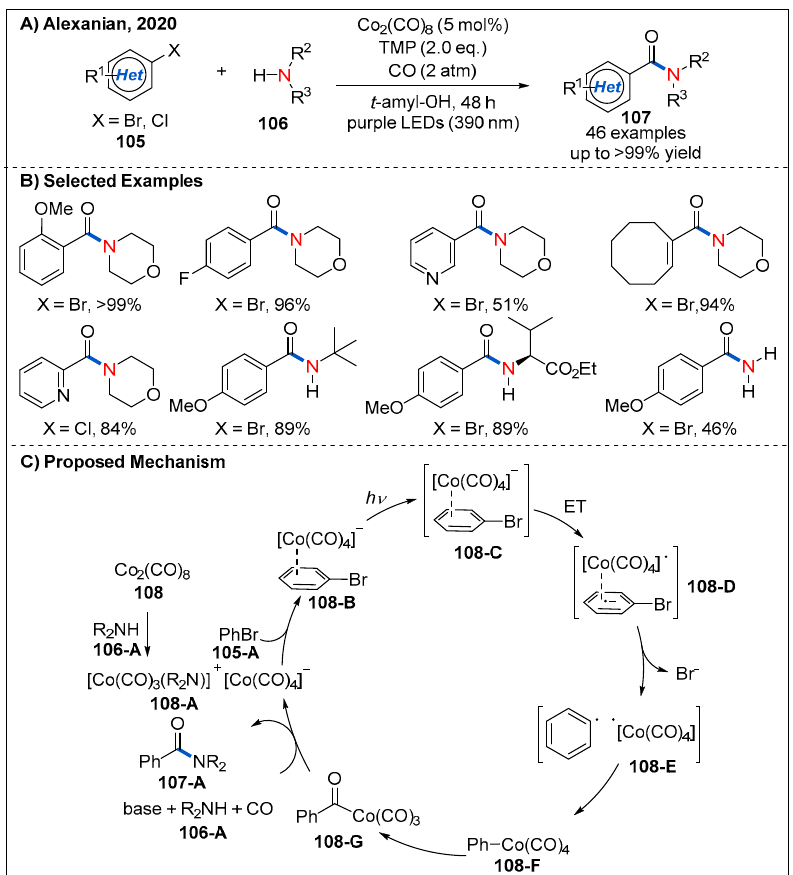
Figure 32. Visible-light-promoted cobalt-catalyzed aminocarbonylation of (hetero)aryl halides.